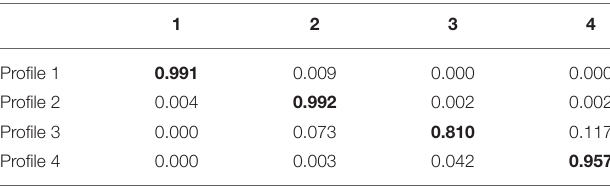
TABLE 7 | Average latent class probabilities for most likely latent class membership (row) by latent profile